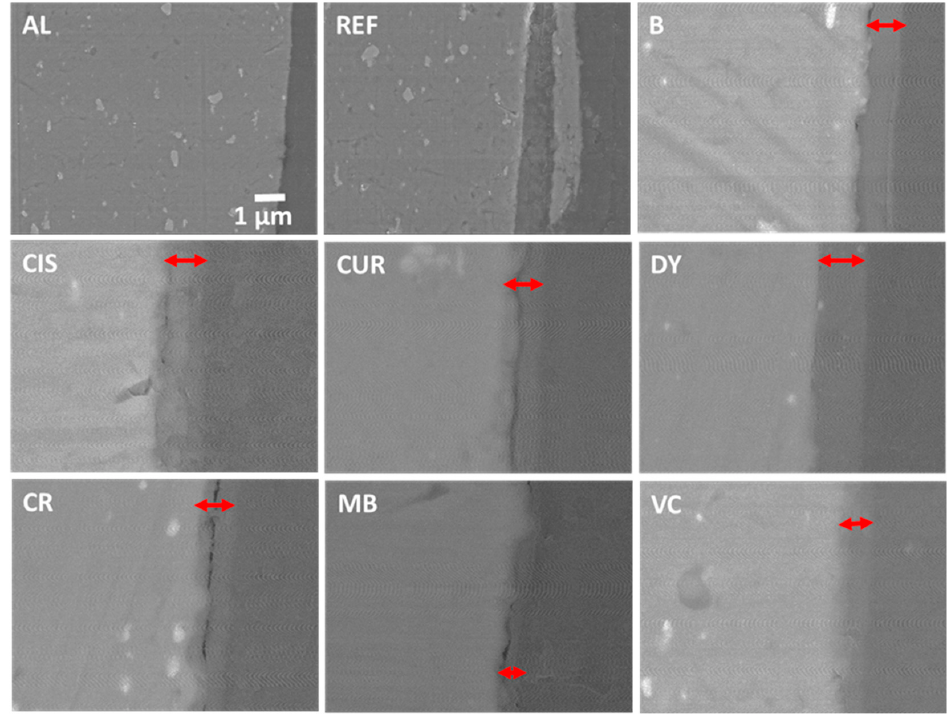
Sample REF, corresponding to the weathered alloy, shows fl akes partially detached from the bulk (sample REF in Figure 7). All coated samples show the sol-gel coatings deposited on the alloys. The lighter and brighter grey colour of the SEM images corresponds to the aluminium alloy substrate (left side of the images). The sol-gel coating with the corre- sponding inhibitor is marked with a red double arrow on all images, and the darkest grey colour corresponds to the organic epoxy resin of the embedding (right side of the images).